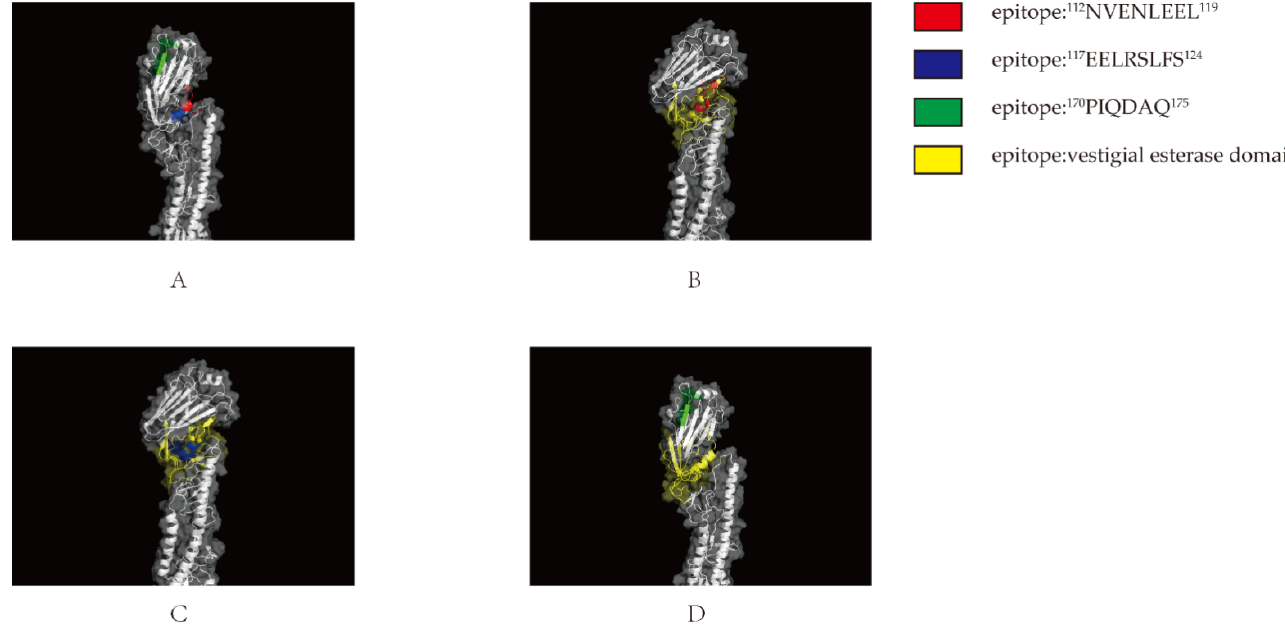
Figure 6. Localization of the identified epitope specific to HA protein: ( A ) epitopes recognized by mAbs 1E11, 2B3 and 3E5. These epitopes were analyzed with “pymol”, in which epitope recognized by 1E11 was marked in red, and epitope recognized by 2B3 was marked in blue, and epitope recognized by 3E5 was marked in green; ( B ) epitopes recognized by 1E11 mAb located in vestigial esterase domain (marked in yellow) and also exposed on the surface of HA protein; ( C ) epitopes recognized by 2B3 mAb located in vestigial esterase domain (marked in yellow) and also exposed on the surface of HA protein; and ( D ) epitopes recognized by 3E5 mAb located in the head of HA and exposed on the surface of HA protein.